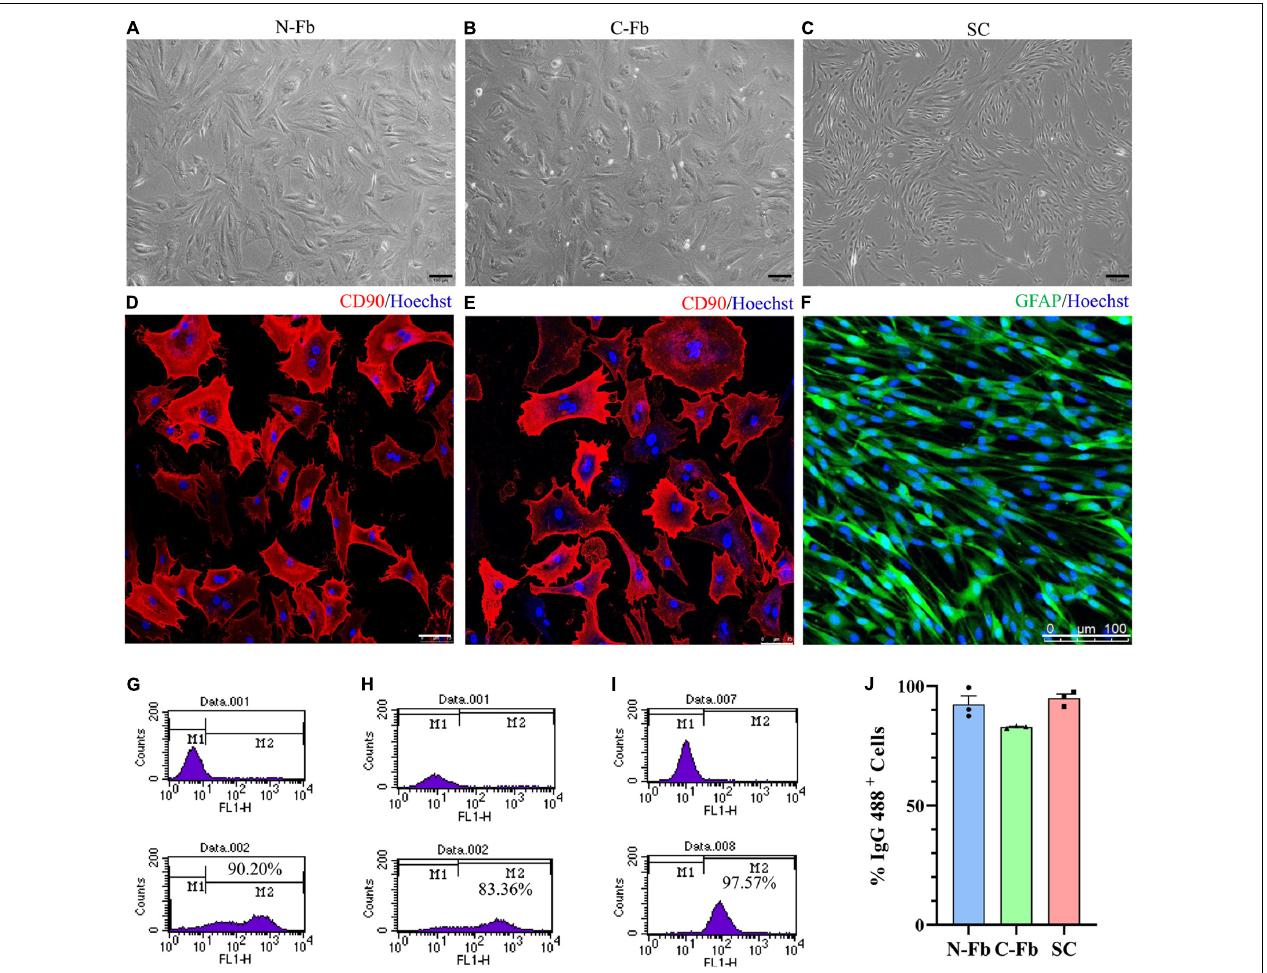
FIGURE 1 | Cell characterization and purification. Phase-contrast micrographs of live primary cultured N-Fbs (A) , cardiac fibroblasts (B) , Schwann cells (C) . Scale bar, 100 µ m. Immunofluorescence for fibroblast marker CD90 in purified N-Fbs (D) , C-Fbs (E) , and SC marker GFAP in purified SCs (F) . Scale bar: (D,E) 75 µ m; (F) 100 µ m. Representative figures of flow cytometry analysis of purified N-Fbs (G) , C-Fbs (H) , SCs (I) . The upper graphics are control groups, and the lower graphics are experimental groups. M1/M2 stood for the area under the curve in upper/lower graphics; the percentage of M2 relative to M1 + M2 was the percentage of IgG 488-positive cells. (J) The purity of N-Fbs, C-Fbs, and SCs (three independent